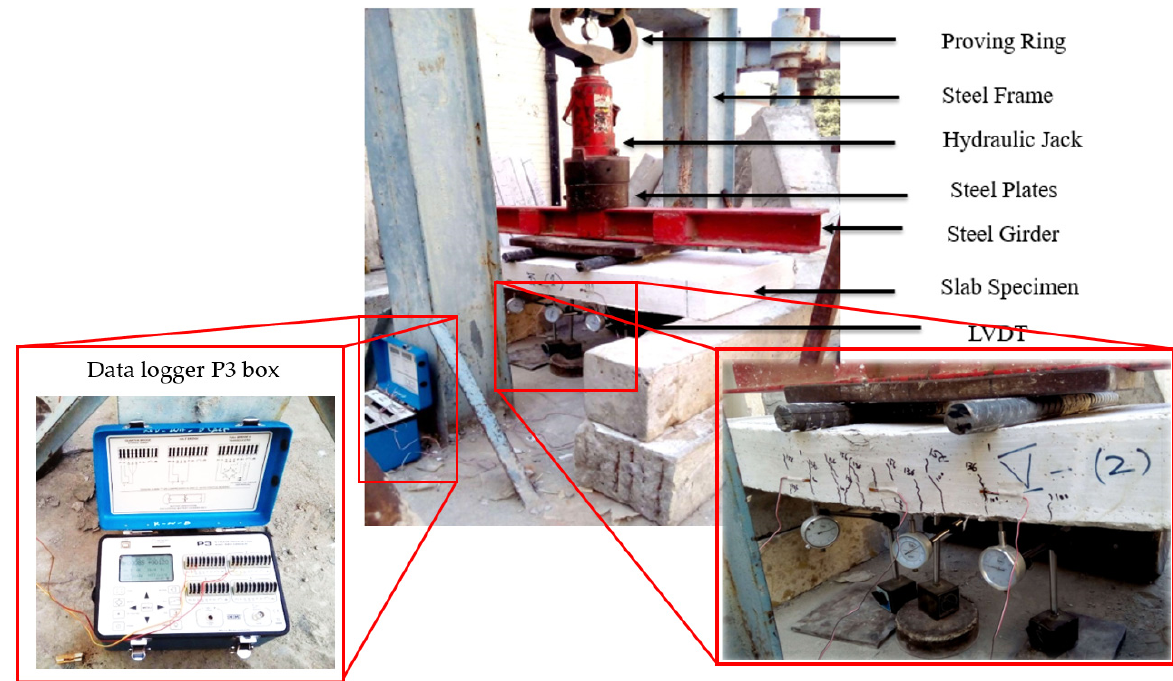
Figure 7. Testing setup for slab specimens.